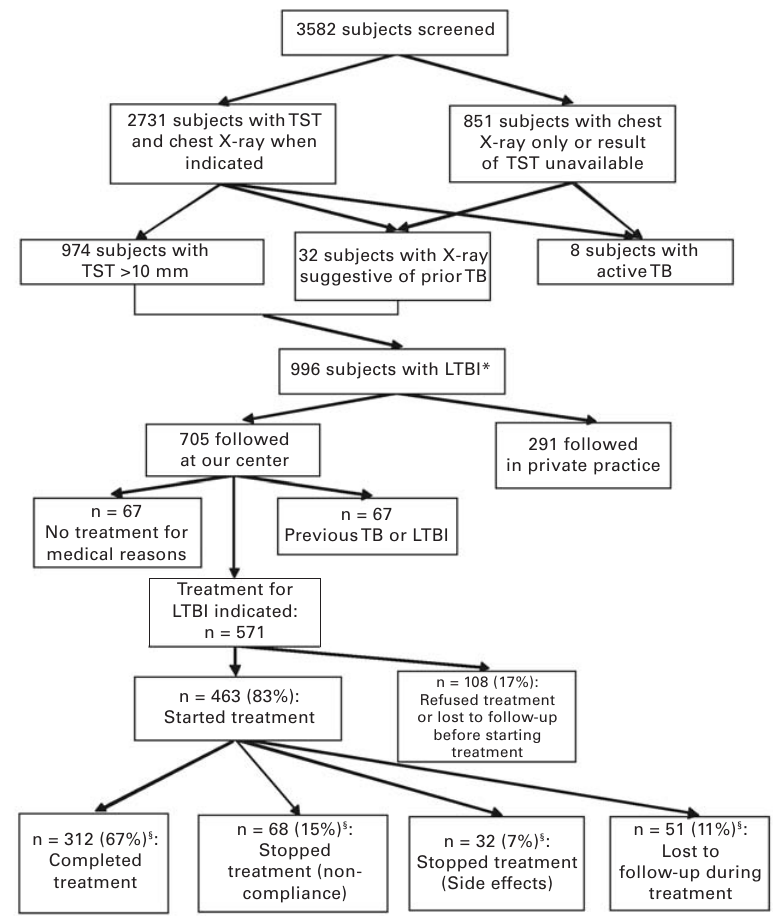
Figure 2 Flow chart of subjects screened for latent tuberculosis infection (lTBi) orTB and out- come of follow-up of patients treated for lTBi. *: Subjects with lTBi hadTST >10 mm and/or chest X-ray suggestive of priorTB. § : percentages refer to patients who started treatment.